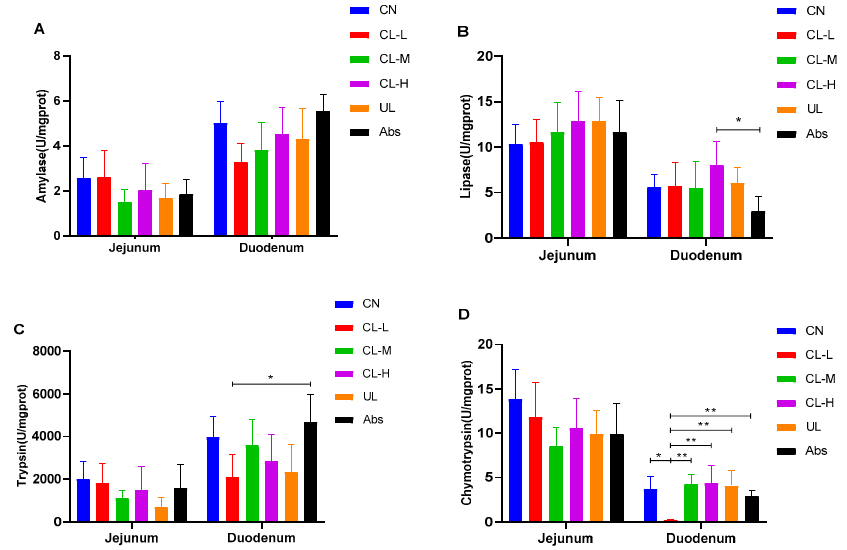
Figure 3. Effects of the CN, CL-L, CL-M, CL-H, UL, and Abs dietary interventions on ( A – D ) amylase, lipase, trypsin and chymotrypsin activities in the duodenum and jejunum. The data are presented as the means ± SE ( n = 6). * indicates significant differences ( p < 0.05), ** represents very significant differences ( p < 0.01).